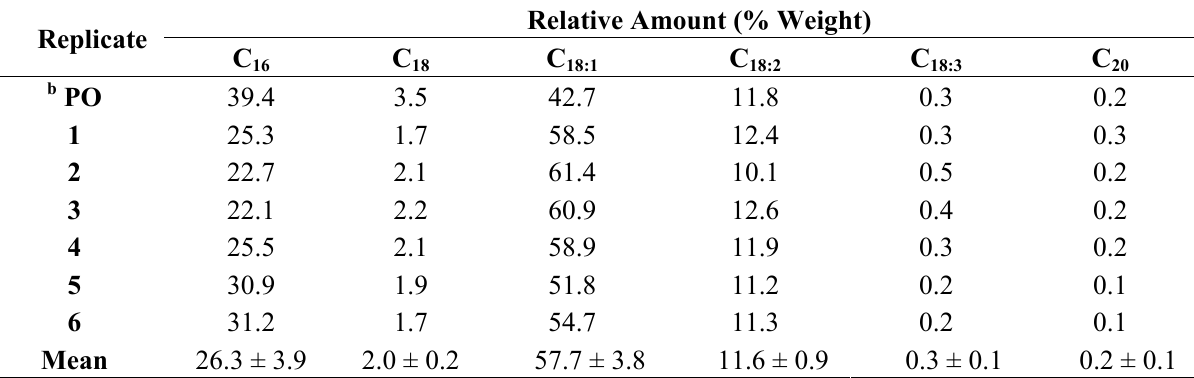
Table 5. Composition of FFA fractionated from lipid materials following neutralisation and fractionation procedure a .